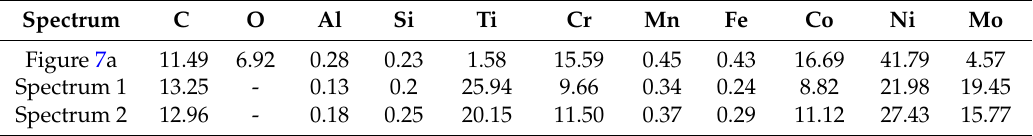
Figure 7. Nimonic 263 surface, processed by laser energy of 25 mJ at wavelength of 532 nm and 50 accumulated pulses (power density 2.4 GW/cm 2 ): ( A ) microstructure; ( B ) grains; and ( C ) twinned grains. Table 5. EDS analysis of the area presented in Figure 7a and the spots shown in Figure